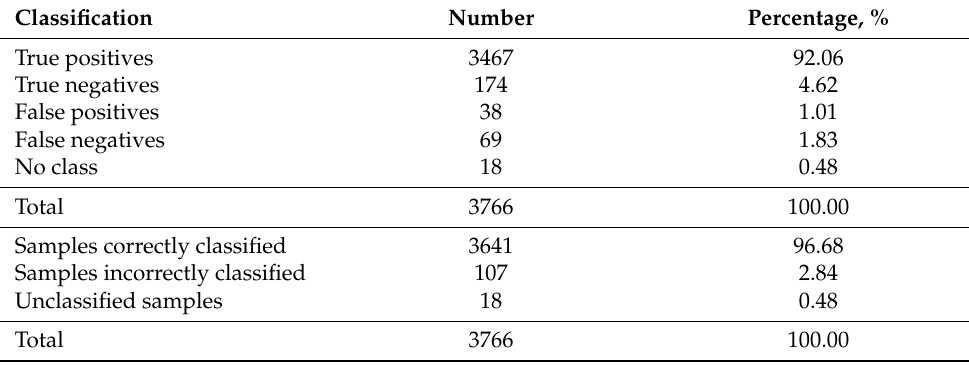
Table 7. Samples classification by the PLS-DA model in the laboratory test.